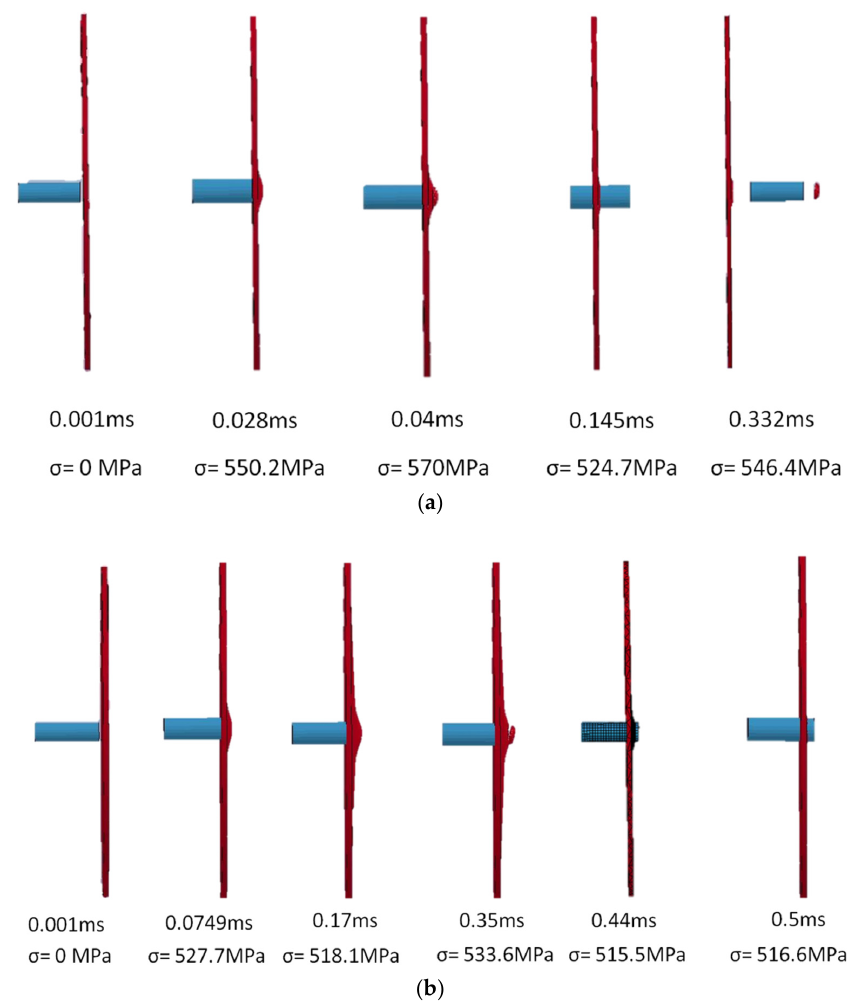
Figure 11. Detailed perforation of the projectile in to 3.18 mm target thickness for an impact velocity of ( a ) 200 m/s and ( b ) ballistic limit of 87.3 m/s. of ( a ) 200 m/s and ( b ) ballistic limit of 87.3 m/s.